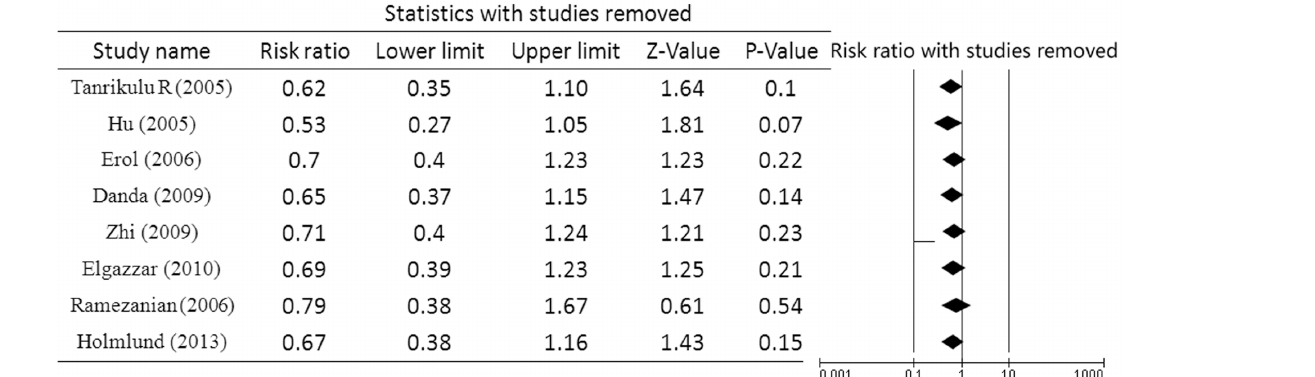
Fig 8. Sensitivity analysis of the influence of individual studies on the pooled estimates for reankylosis.